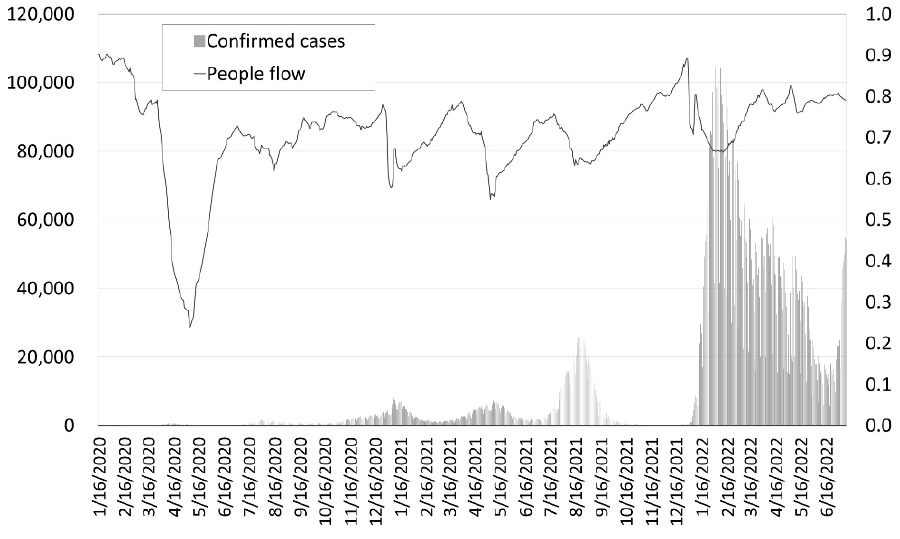
Figure 1. Number of confirmed cases in Japan.